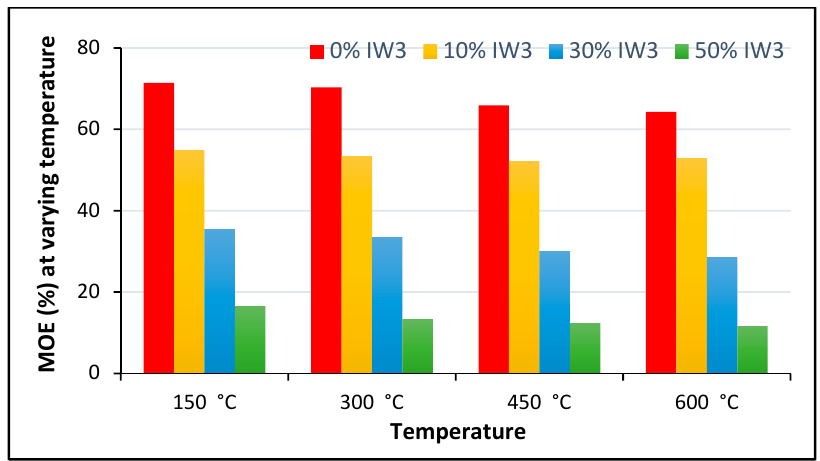
Figure 12. Elastic modulus of RHA-modified concrete at various w/b ratios [233].